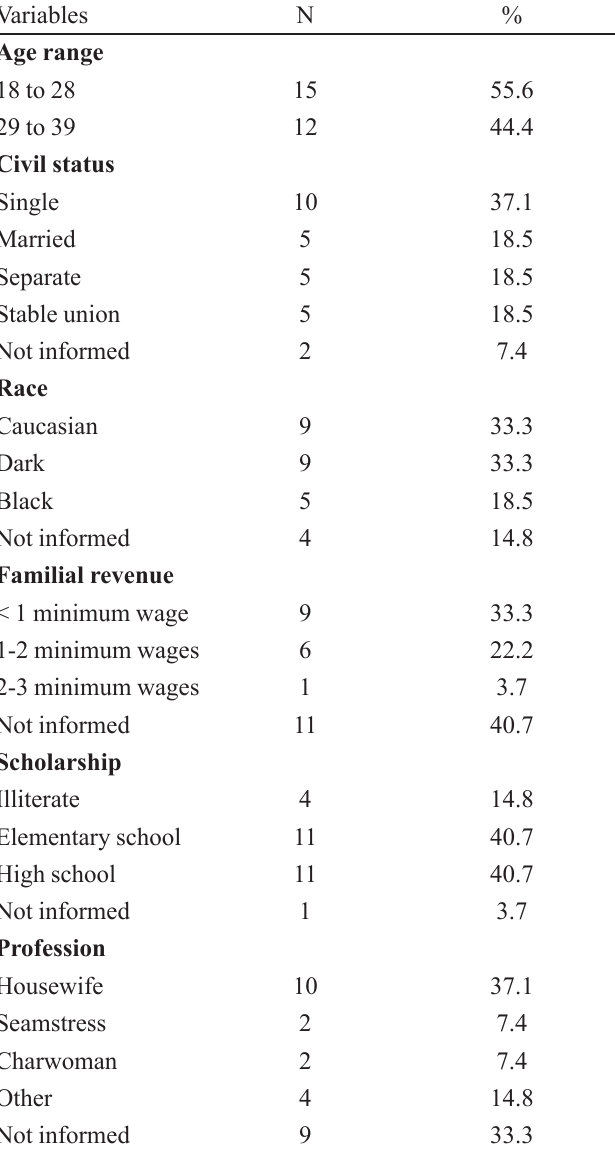
TABLE II - Distribution of patients carrying human immuno- deficiency virus (HIV) according to obstetric history, contamination path, serology identification, prenatal evaluation execution, and the number of prenatal consultations